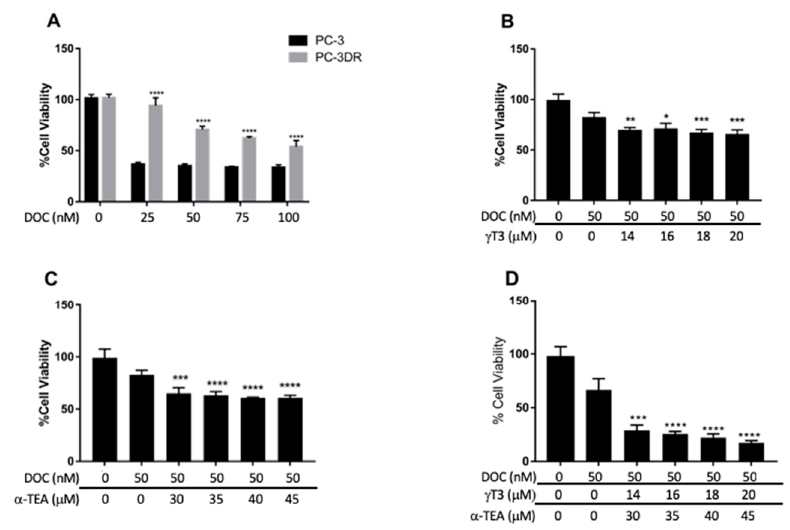
Figure 4. Viability data for DOC-resistant PC-3 (PC-3DR) cells treated using combinations of DOC with α -TEA and / or γ -T3. ( A ) PC-3 and PC-3DR cells treated with 25, 50, 75, and 100 nM DOC. PC-